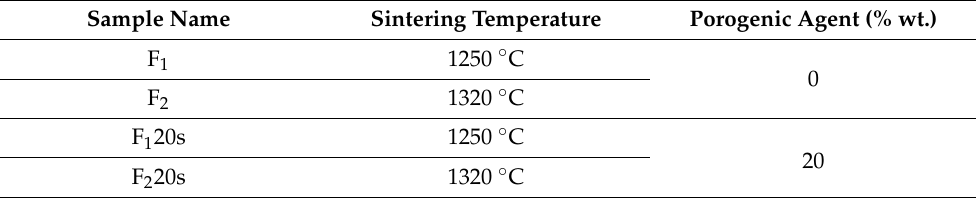
Table 1. Sample formulation and thermal conditions for obtaining ceramic